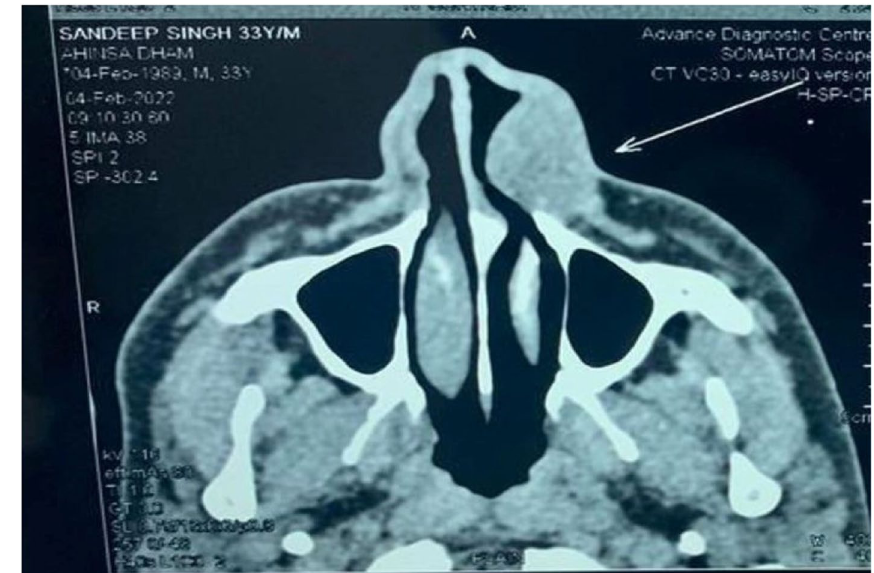
Fig. 2 Axial cuts of computed tomography scan of the nose and paranasal sinuses showing a mass arising from within the lateral wall of the left nasal